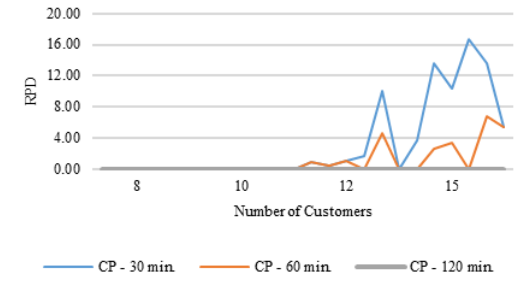
Figure 2. RPD results of the CP model under 30-, 60-, and 120- minutes